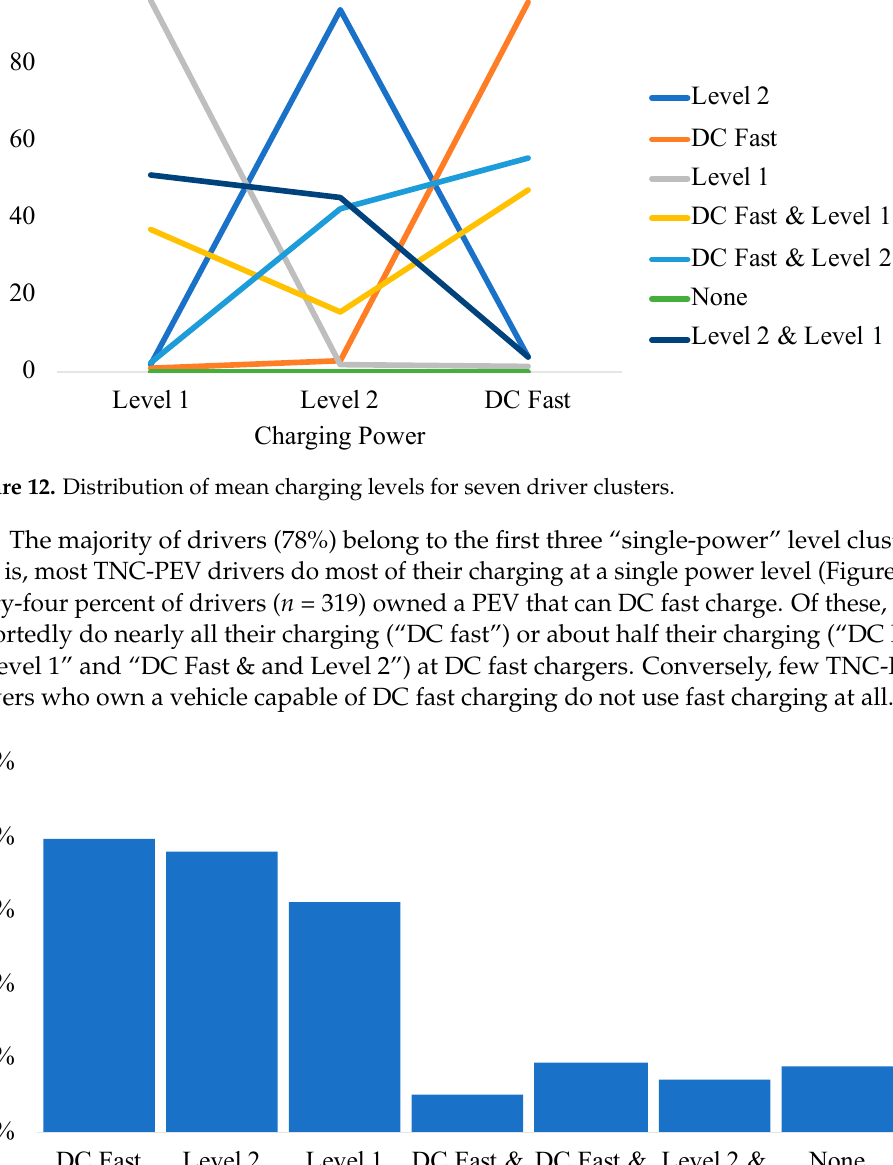
Figure 11. Mean distribution of charging time of day.